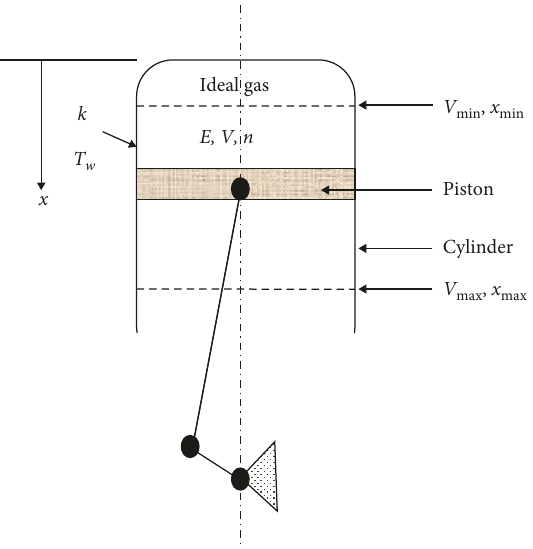
Figure 1: Schematic of the reciprocating engine cylinder.